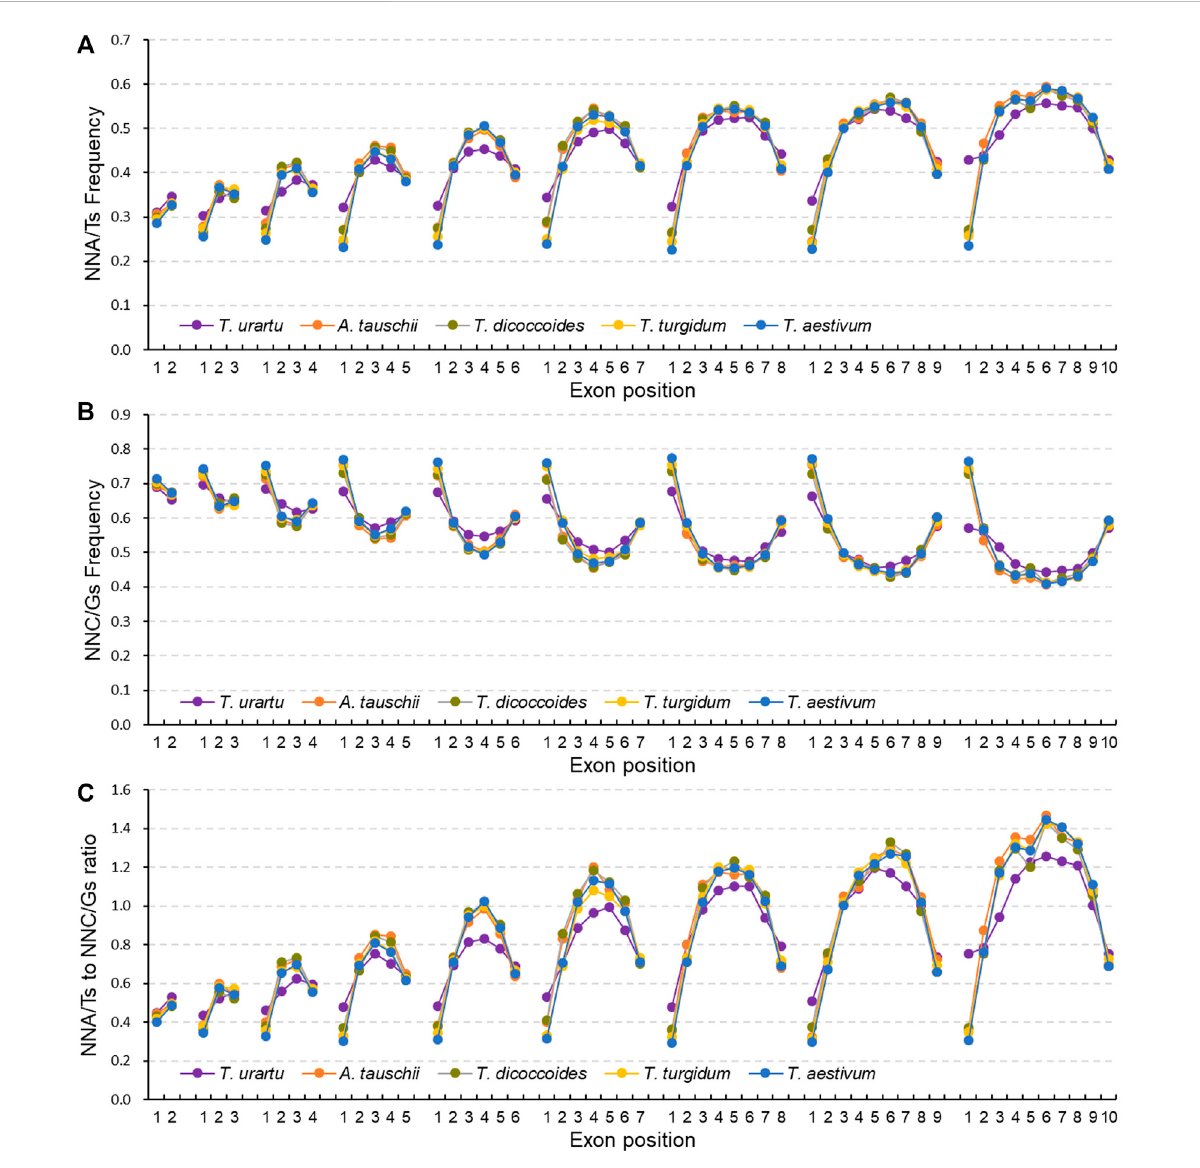
FIGURE 3 Heterogeneityof SCUB as a function of exon position in genes. Frequencies of A/T-ending SCs (NNA/Ts) (A) and C/G-ending SCs (NNC/Gs) (B) as a function of exon position in geneswith one to nine introns. (C) Ratios betweenA/T-ending SCs and C/G-ending SCs (NNA/Ts and NNC/Gs) as a function of exon position in genes with one to nine introns. N denotes any base. The difference between hexaploid wheat and its progenitors was calculated by Chi square ( χ 2 ) test, and the results are presented in Supplementary Table